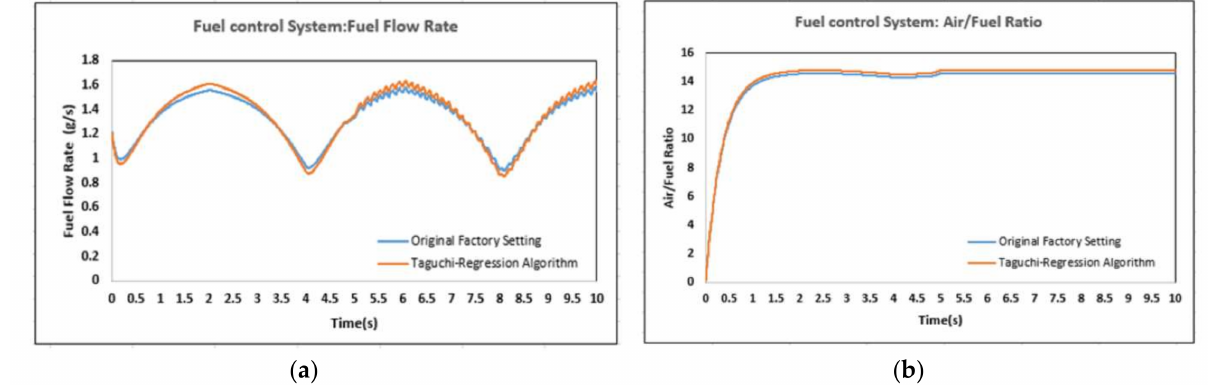
Figure 16. ( a ) Fuel flow rate; ( b ) air/fuel ratio of the fuel injection control